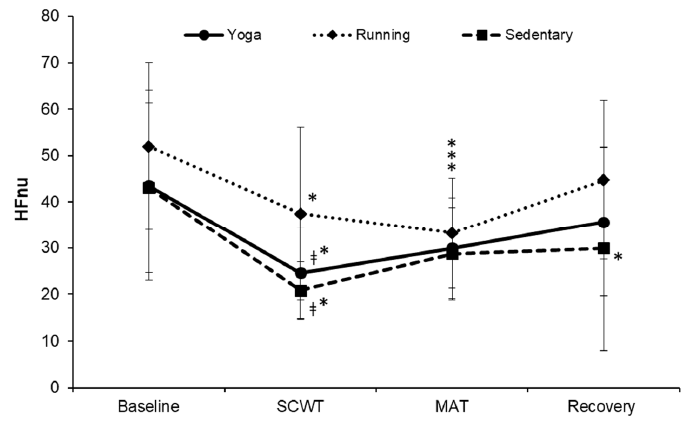
cantly greater in the running group when compared to that of the other two groups (all p